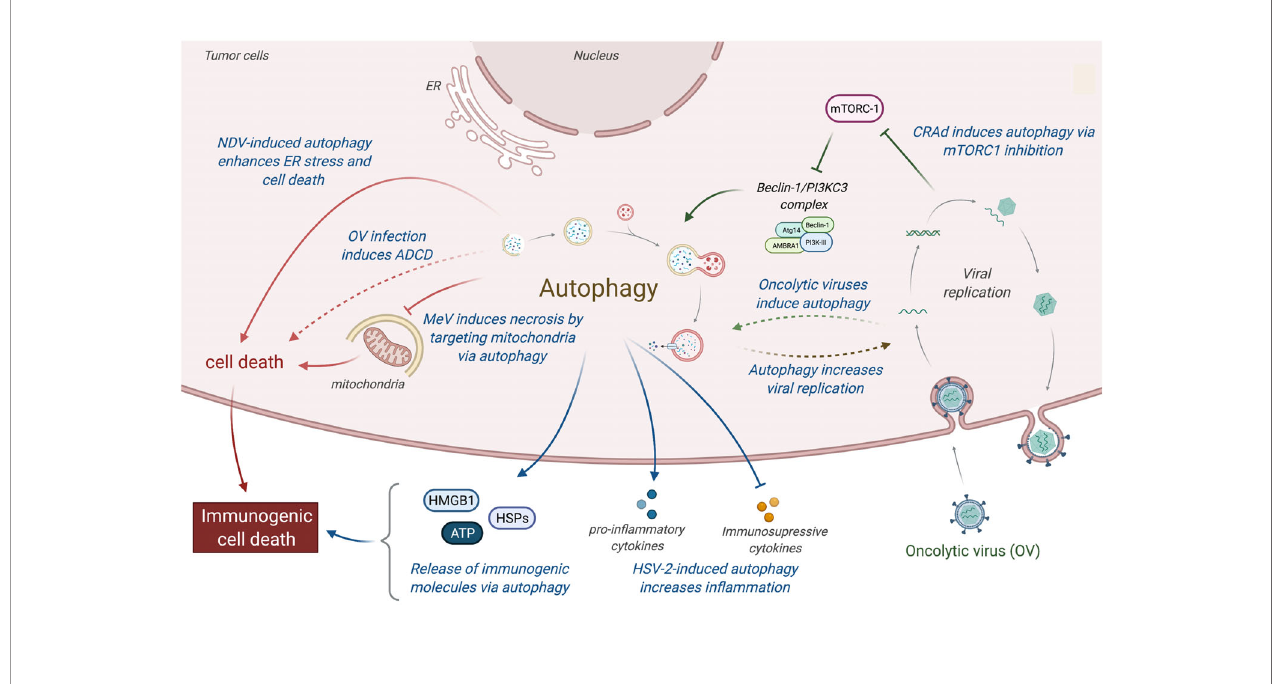
FIGURE 3 | Relations between oncolytic viruses and autophagy in tumor. Oncolytic viruses induce an immunogenic cell death by inducing autophagy, which favors the cell death of tumor-infected cells and the release of immunogenic molecules (e.g., HMGB1, ATP, or HSPs proteins). More speci fi cally, CARds replication induces autophagy by an inhibition of mTORC1, which enhances the induction of cell death and the release of immunogenic molecules. MeV induces mitophagy to eliminate mitochondria, resulting to a decrease of apoptosis and an increase of necrosis, a more immunogenic cell death. NDV infection increases ER stress, resulting to an induction of autophagic cell death and the secretion of immunogenic molecules. In addition, HSV-2 infection can also perturb the tumor microenvironment by favoring the expression of pro-in fl ammatory molecules (e.g., TNF a , IL-1 b ; and GM-CSF) and limiting the production of immunosuppressive molecules (e.g., IL-10 and TGF b ). CRads, Conditionally Replicating Adenoviruses; MeV, Measles Virus; NDV, Newcastle Disease Virus; HSV-2, Herpes Simplex Virus 2; ADCD, autophagy-dependent cell